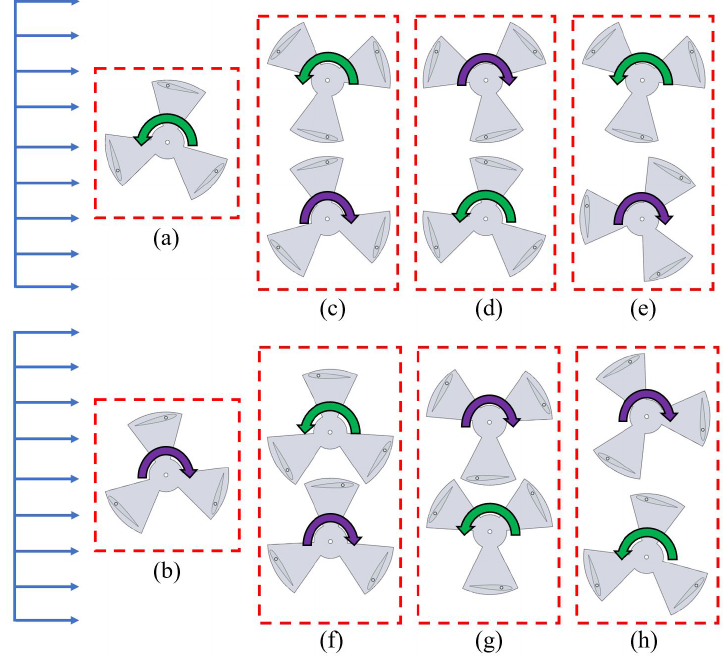
Figure 9. Different turbine configurations used in the power measurement experiment: ( a ) Single turbine T1, ( b ) Single turbine T2, ( c ) Forward counter-rotating at ∆Φ = 0 ◦ , ( d ) Backward counter-rotating at ∆Φ = 0 ◦ , ( e ) Forward counter-rotating at ∆Φ = 60 ◦ , ( f ) Forward overlapping at ∆Φ = 60 ◦ , ( g ) Backward overlapping at ∆Φ = 60 ◦ , and ( h ) Backward counter-rotating at ∆Φ = 60 ◦